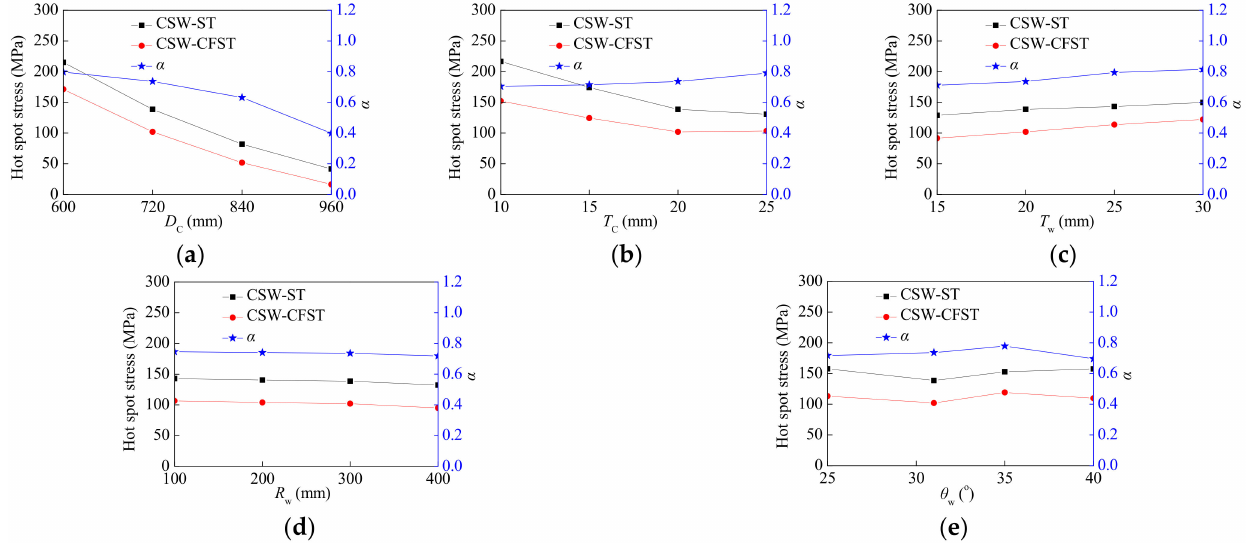
Figure 22. Sensitivity of hot-spot stress at point S to geometric parameters: ( a ) chord diameter; ( b ) chord wall thickness; ( c ) corrugated steel web thickness; ( d ) transition curve radius; and ( e ) corru- gated steel web dip